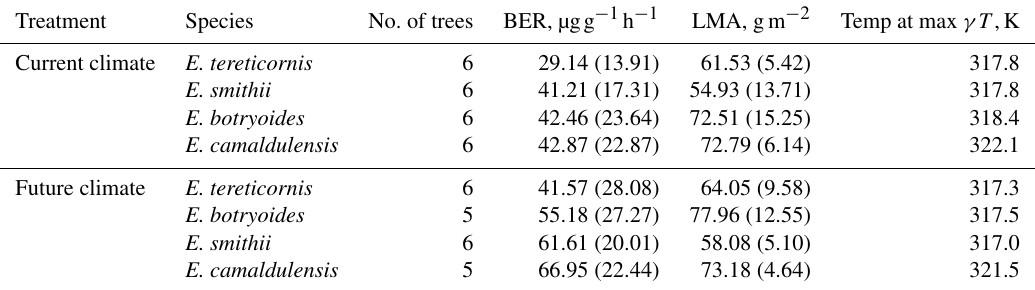
Table 2. Average isoprene basal emission rates (BER), leaf mass per unit area (LMA) and temperature at maximum γT from each pool of trees under the current- and future-climate growth conditions. Values in brackets are standard deviations. Data in the right-hand column are derived from model